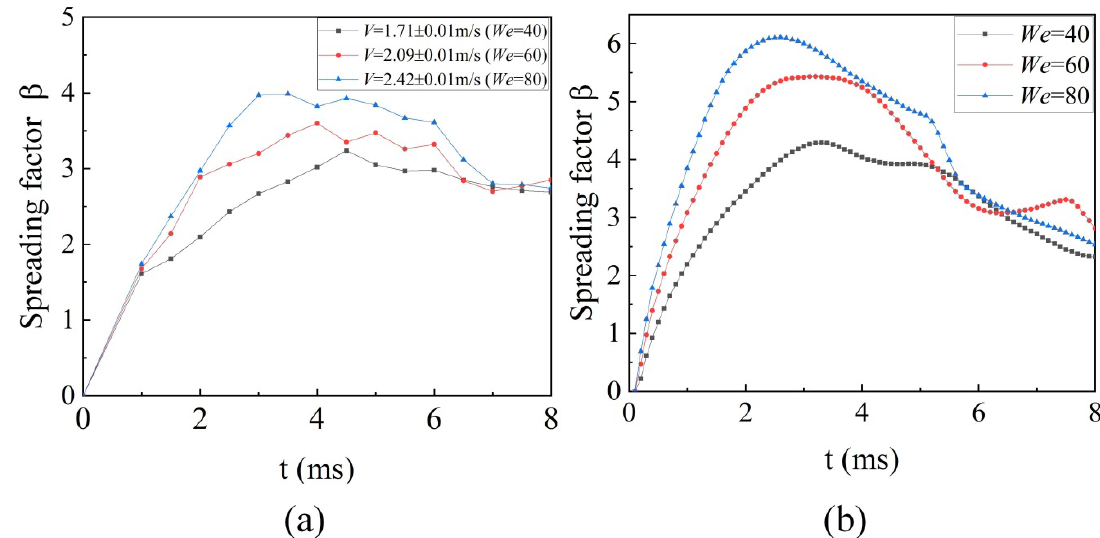
Figure 4. Spreading factor against time for different Weber numbers. (Comparison between the experimental data ( a ) and the numerical simulations ( b ).)